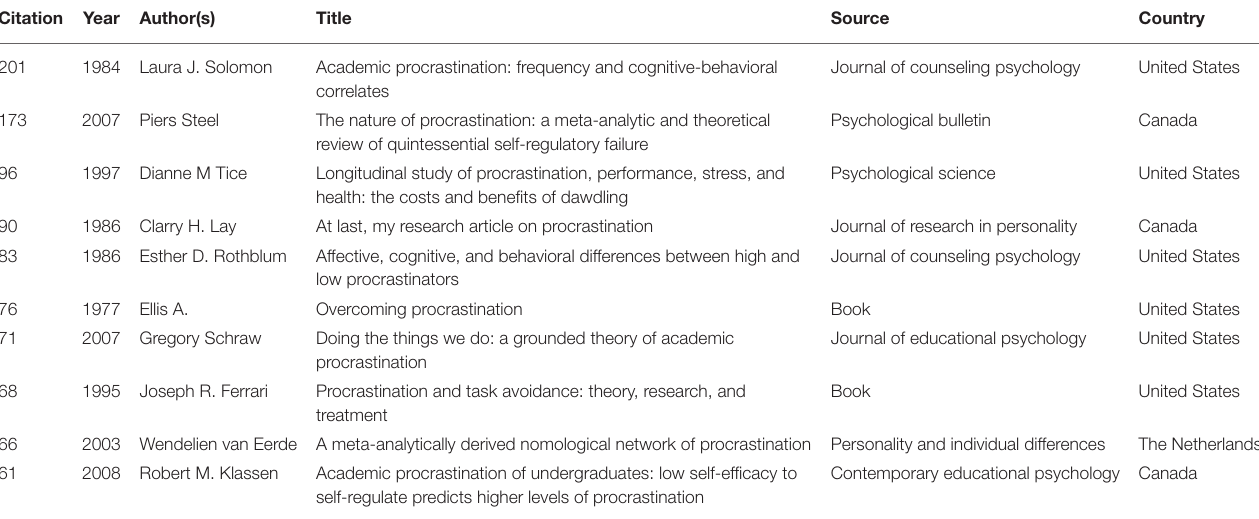
TABLE 7 | Top 10 cited